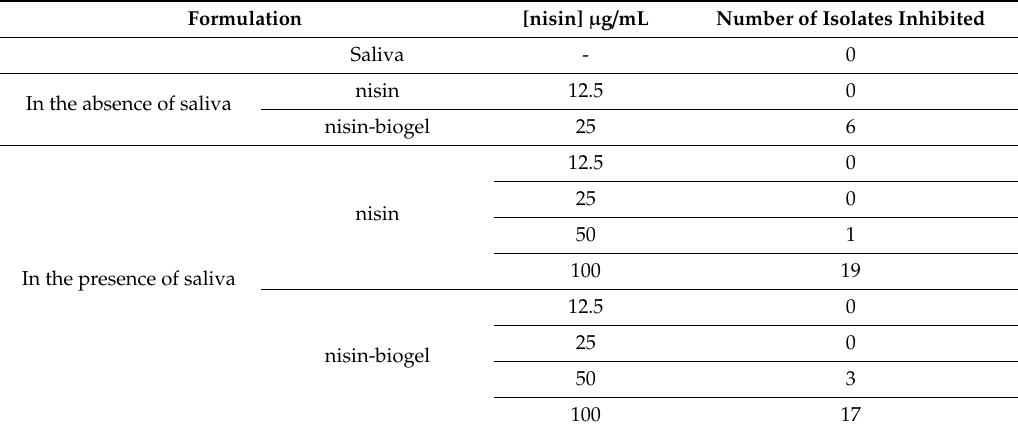
Table 1. Distribution of the number of isolates inhibited by the nisin and nisin-biogel solutions, diluted or not in saliva. Saliva was also included as a